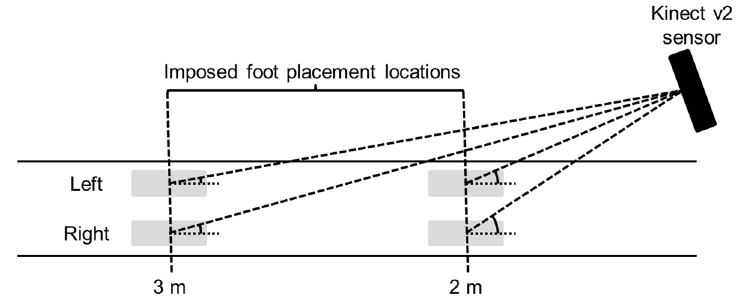
Figure 5. An overview of the influence of distance from the sensor and body side on body orientation relative to the Kinect sensor.